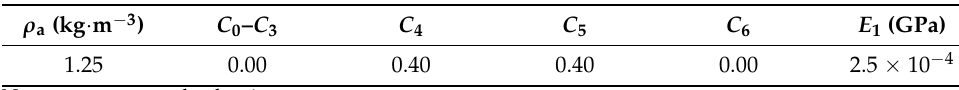
Table 5. Parameters of standard air.